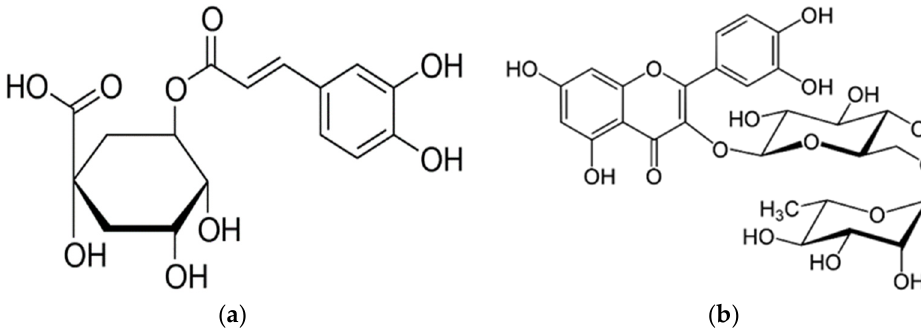
Figure 2. Chemical structure of chlorogenic acid ( a ) and rutin ( b ).